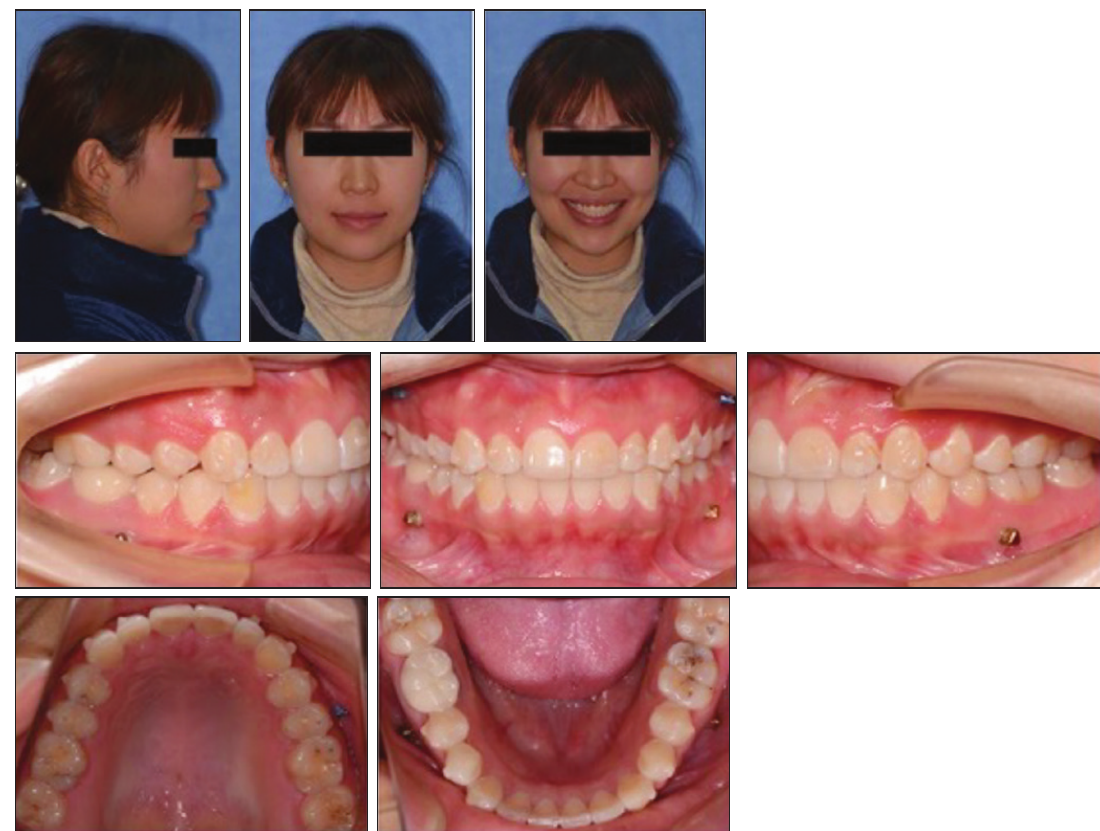
Figure 5. Facial and intraoral photographs before the first refinement during